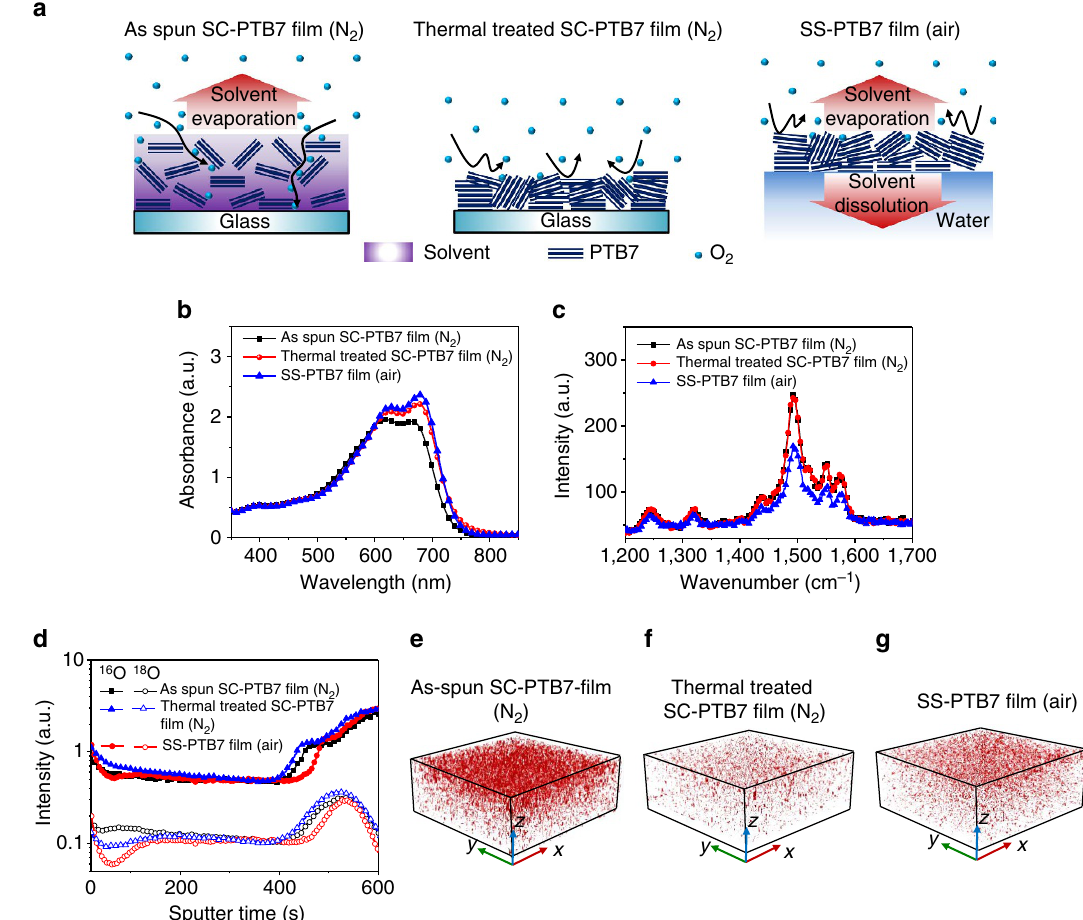
Figure 3 | Oxygen diffusion into polymer films via solvent. ( a ) Oxygen diffusion mechanism in PTB7 films during drying process for spin-coated PTB7 films treated under different conditions and for SS-PTB7 film. ( b ) Ultraviolet–visible absorption spectra and ( c ) Raman spectra of spin-coated PTB7 films treated under different conditions, ( d – g ) TOF-SIMS depth profile and 3D iso-surface overlay of oxygen ions ( 16 O and 18 O) intensity as a function of sputter time for the spin-coated PTB7 films treated under different